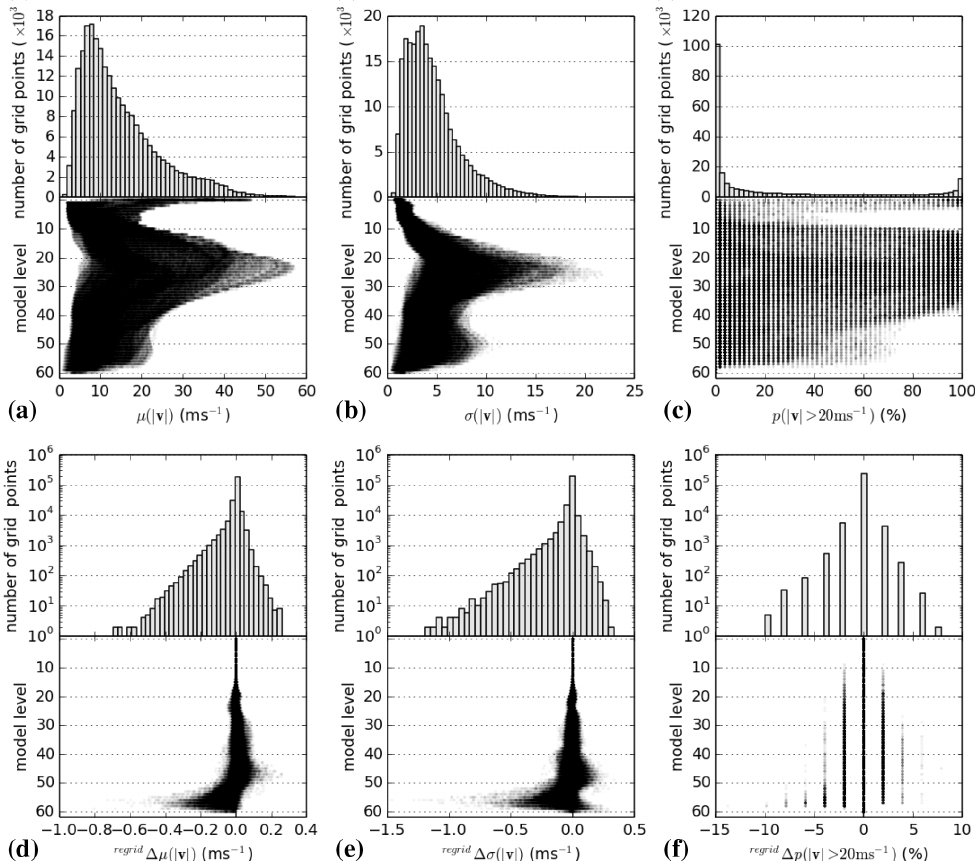
Figure 15. Distribution of differences between statistical quantities computed from a vertically regridded ensemble to those computed from the original ensemble. Plots are generated from all 256742 grid points of the data field. Same forecast as in Fig. 13. Shown are ( a and d ) µ( | v | ) , ( b and e ) σ( | v | ) and ( c and f ) p( | v | > 20ms − 1 ) ; (a–c) distribution and vertical occurrence of absolute values of the quantities. (d–f) Distribution and vertical occurrence of differences due to regridding (denoted by regrid (cid:49) ); note the logarithmic scale of the histograms in (d–f) . Probability values are discrete due to the size of the ensemble (51